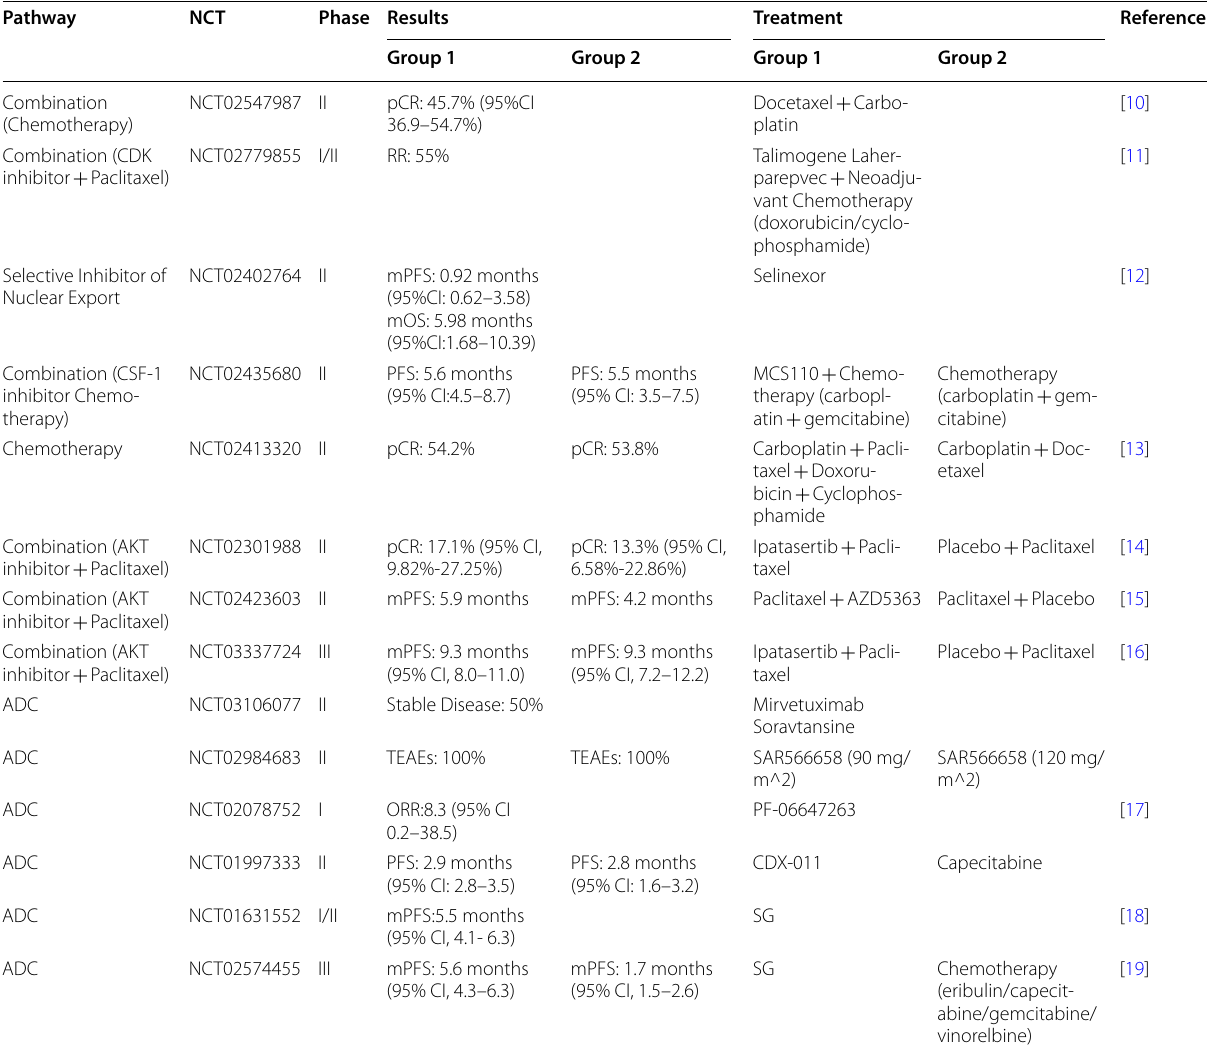
Table 1 Partial clinical trials of targeted agents involving patients with TNBC